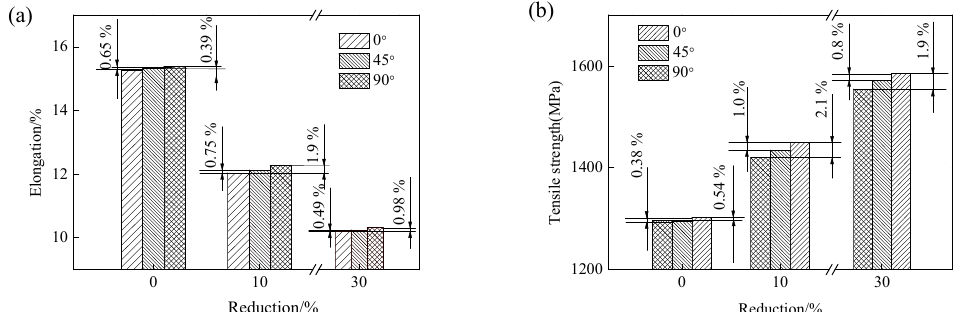
Figure 8. Elongation ( a ) and tensile strength ( b ) of low-carbon martensitic steel in the directions at angles 0°, 45°, and 90° with respect to the RD.